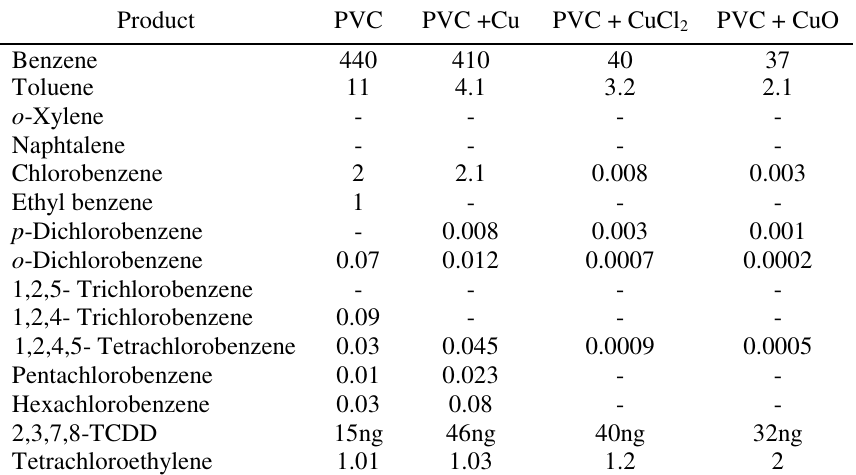
Table 5. The amount ( µ g) of organic gases products from the combustion of pure PVC and mixture of PVC in the presence of copper, copper(II) chloride and cupric oxide at 300 ° C under